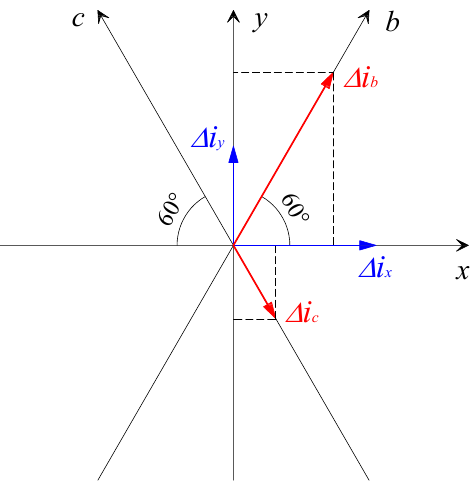
Figure 4. Transformation of